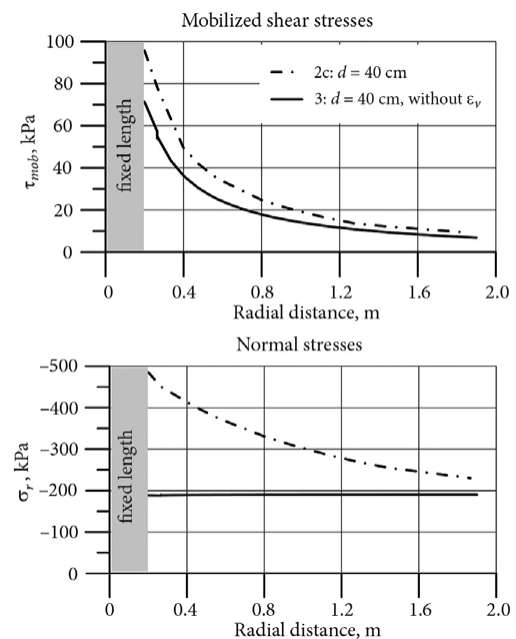
Fig. 13. Distribution of stresses in the horizontal (radial)